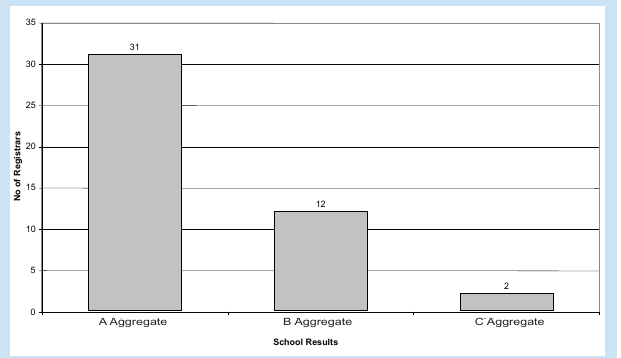
Fig. 3. Registrars attending the college course according to school results. Fig.3.Registeredattendingthecollegecourseaccordingtoschoolresults.